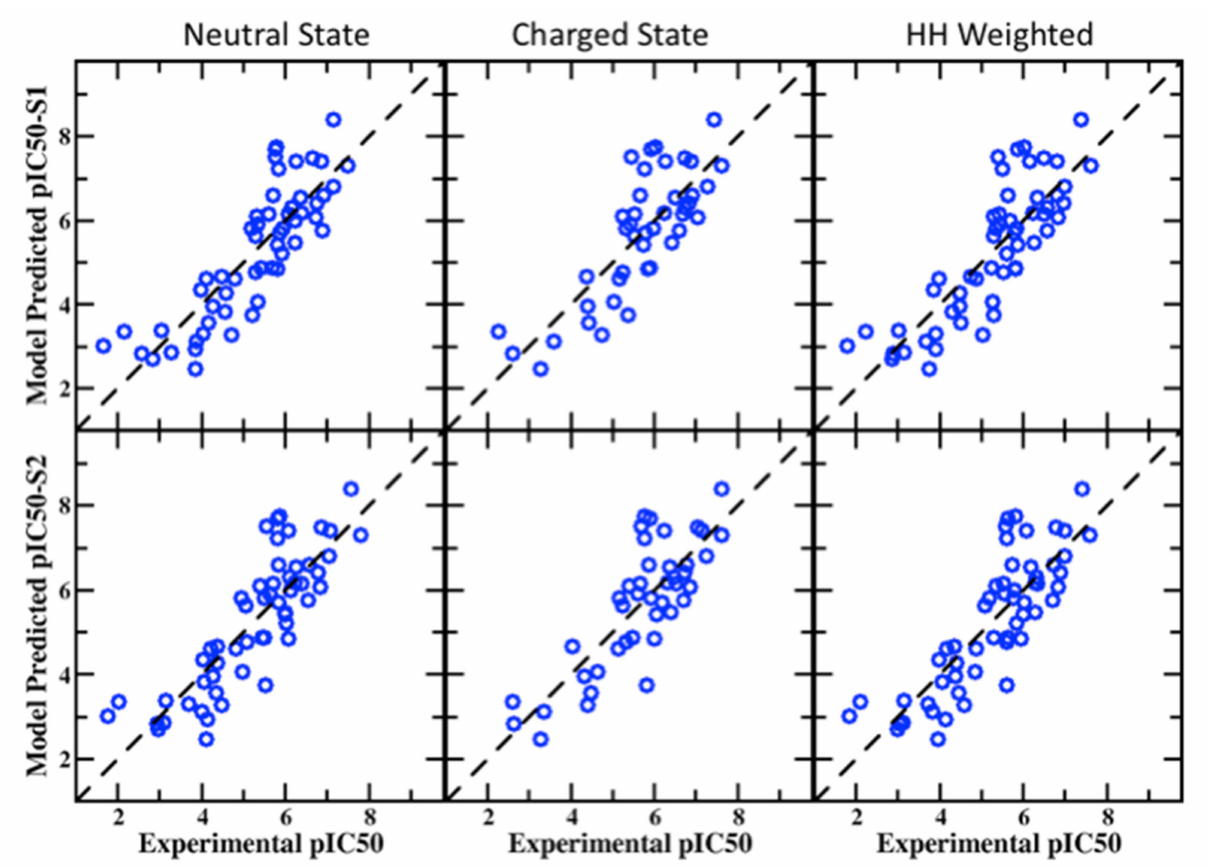
Figure 1. Correlation plots between experimental and predicted pIC50 values from the BML PPM + SILCS LGFE score consensus models for the neutral, charged, and HH-weighted in the S1( top row) and S2 ( bottom row) pockets in the hERG channel. Table 3. Statistical analysis for 77, 80, and 32 blockers in S1 and S2 binding pockets using the